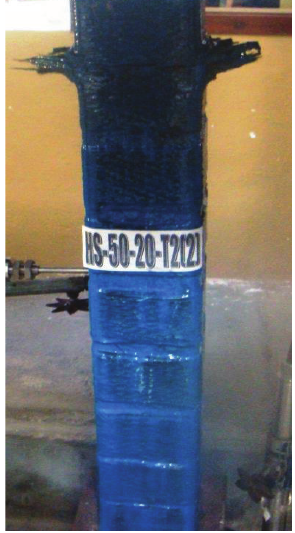
Figure 6: Failure mode of column HS-50-20-T2 (2) .